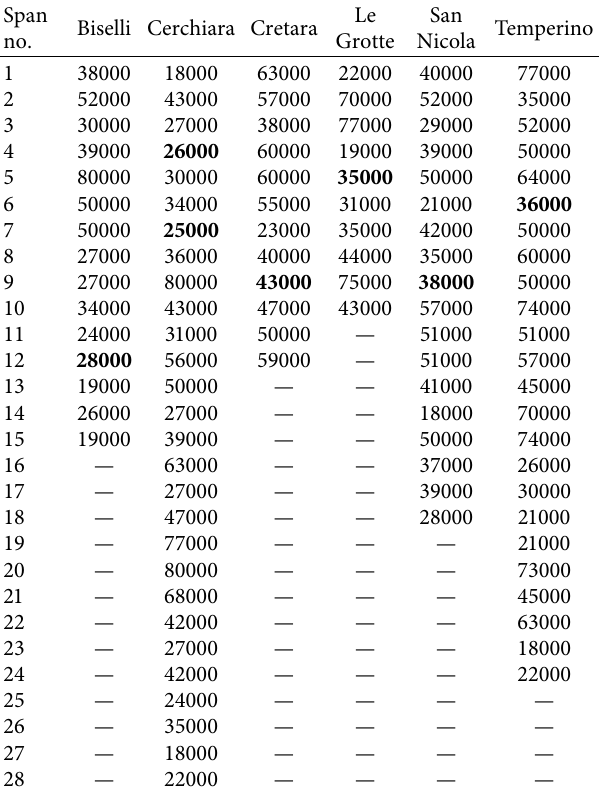
Figure 9: Cross-correlation functions corresponding to the Le Grotte viaduct. Table 4: Elastic moduli in MPa identified using the instrumented vehicle.